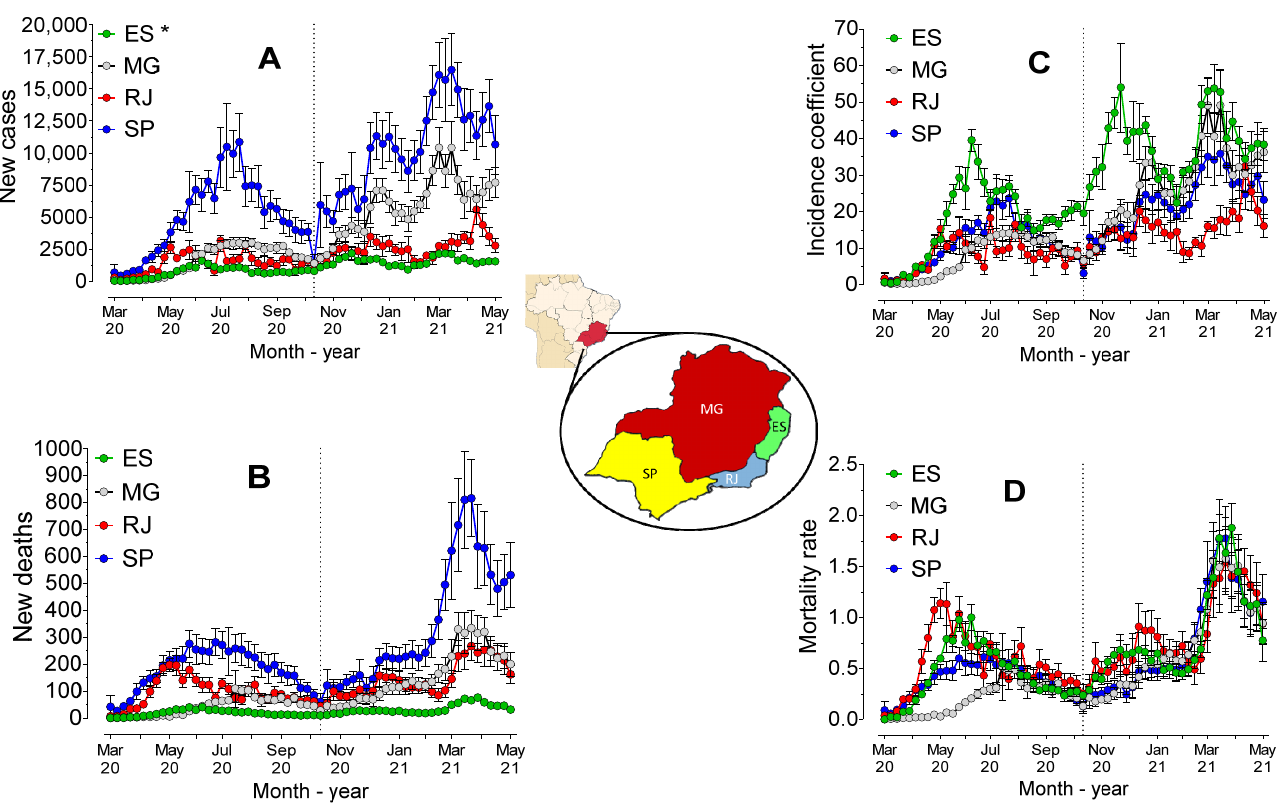
Figure 2. Mean (± standard error) of cases ( A ) and new deaths ( B ), incidence coefficient ( C ) and mortality rate ( D ), over the course of 62 weeks of the pandemic in the 4 states of the Southeast region. * ES = Espírito Santo, MG = Minas Gerais, SP = São Paulo; RJ = Rio de Janeiro.